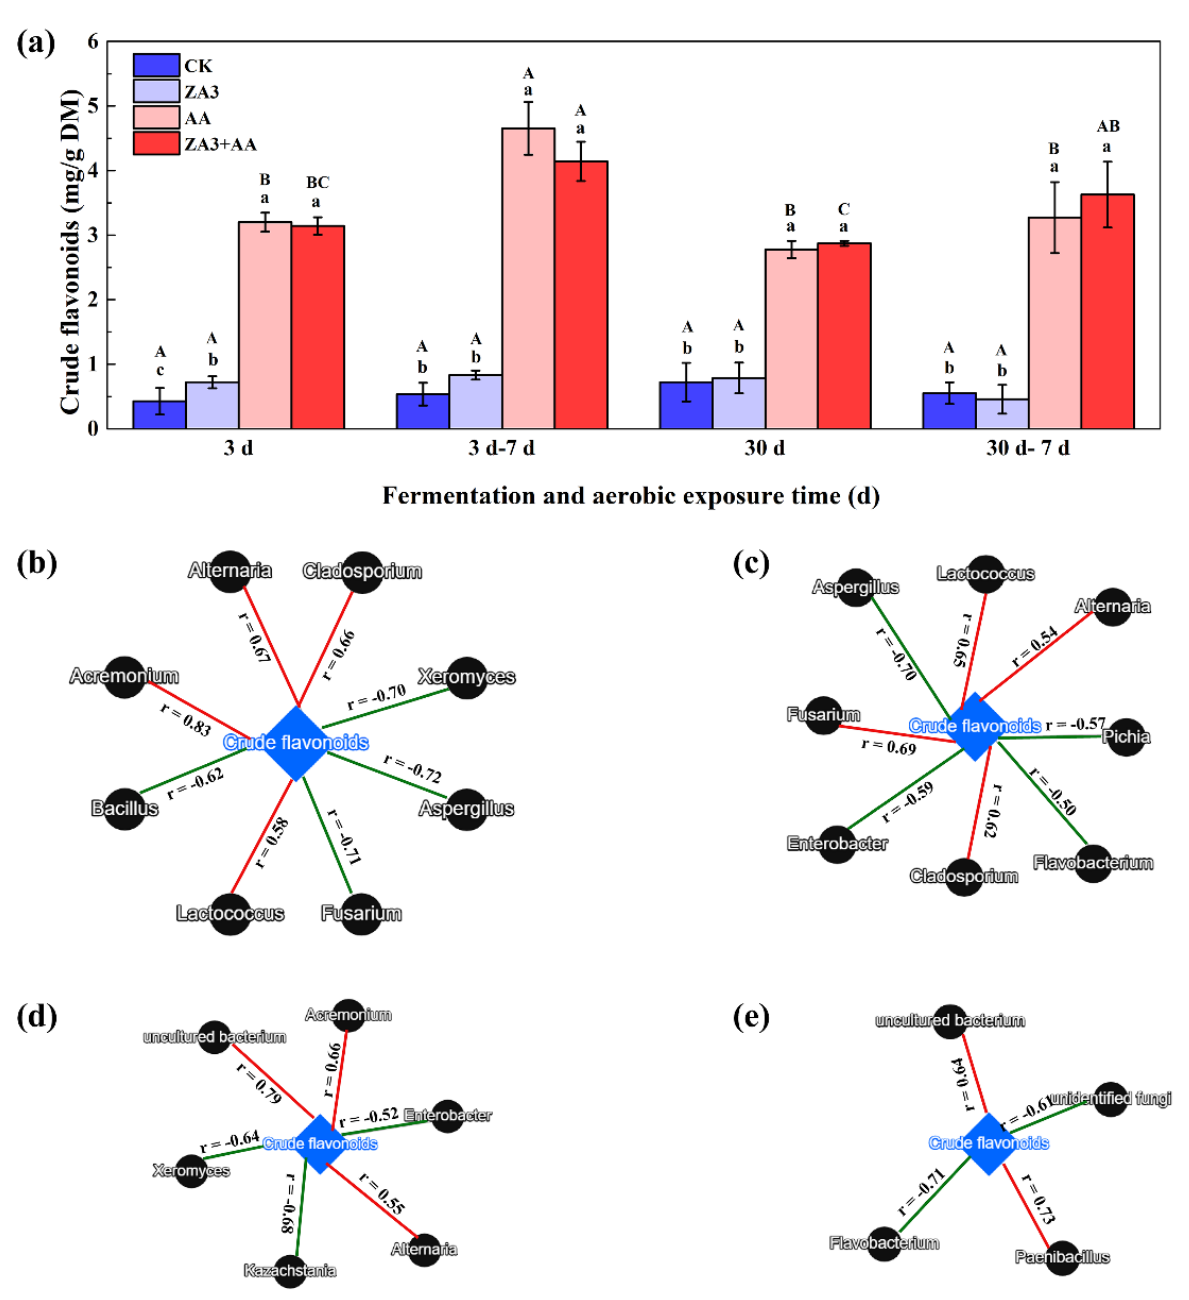
Figure 9. Content of crude flavonoids and linkages with microbial during fermentation and aerobic exposure. ( a ), crude flavonoids (mg/g DM). ( b – e ), co-occurrence networks analysis the top 10 en- riched bacteria and fungi at the genus level with crude flavonoids in 3 d and 30 d of fermentation,